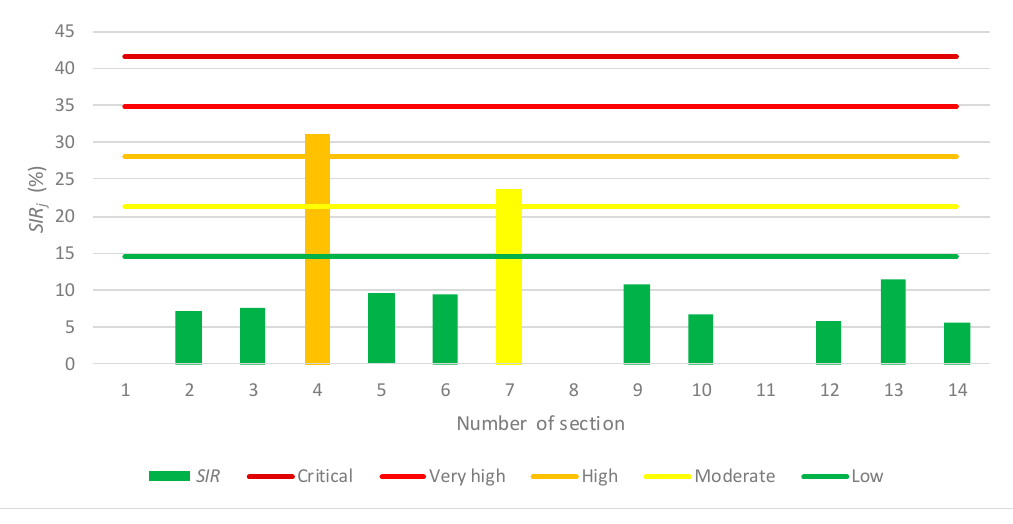
Figure 6. SIR j of ROAD7.